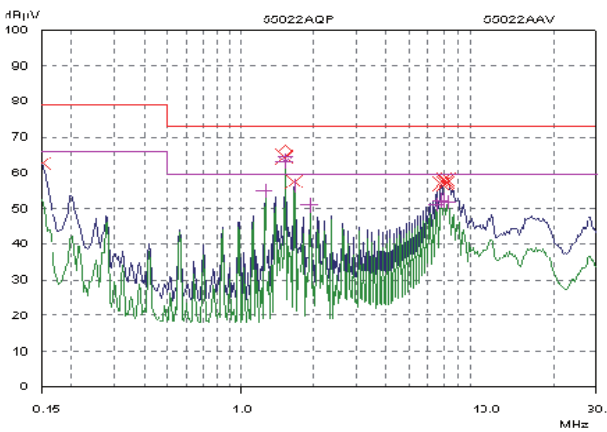
Fig. 3. Measured conducted EMI results from the input